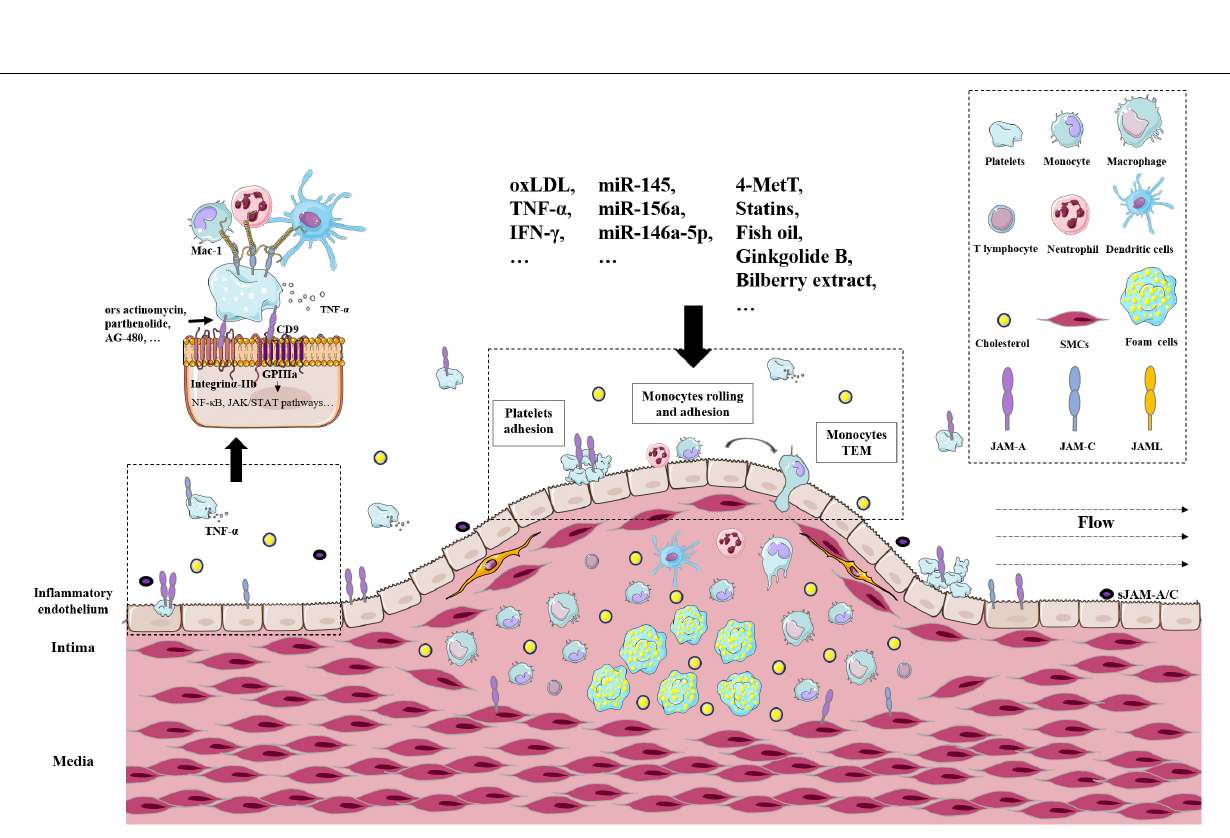
Frontiers in Cardiovascular Medicine |